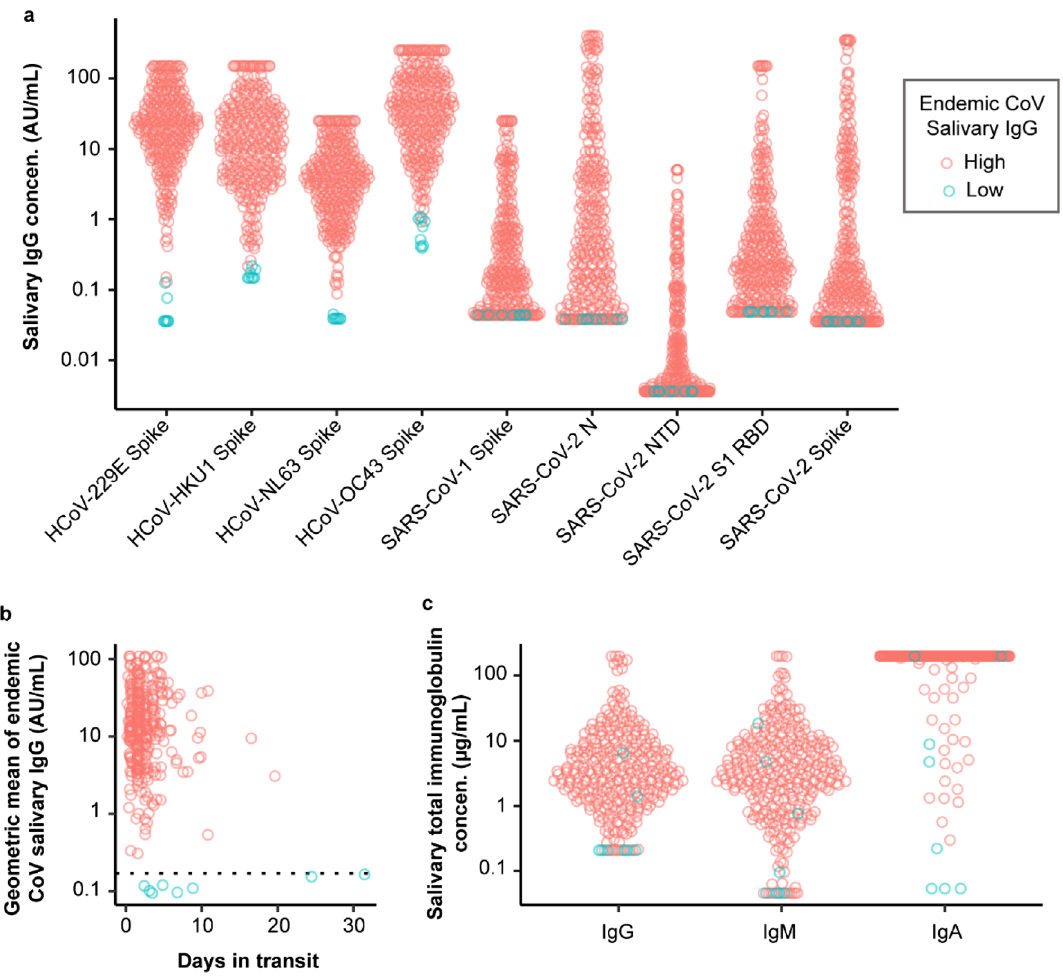
Figure 4. Concentrations of anti-spike and anti-N IgG measured in saliva of patients tested for SARS-CoV-2. Saliva was self-collected and returned via mail to a laboratory for analysis. For indirect serology, recombinant proteins representing the receptor binding domain (RBD) and N-terminal domain (NTD) of spike along with full-length spike and N antigen were multiplexed in wells of a 96-well plate. ( a ) IgG antibodies to four endemic coronaviruses were readily detected in nearly all samples. Eight samples (highlighted in blue) showed consistently low levels of antibodies to all coronaviruses. ( b ) 91% of samples were in transit for five days or less, and transit time was not strongly correlated with the mean level of salivary IgG for the four endemic coronaviruses (CoVs). Dotted line indicates geometric mean for the 5th percentiles of endemic CoV salivary IgG measured in a prior study of presumed naïve controls without prior diagnosis, household exposure, or symptoms of COVID-19 35 . ( c ) Total levels of immunoglobulins (IgG, IgM, and IgA) were also measured in